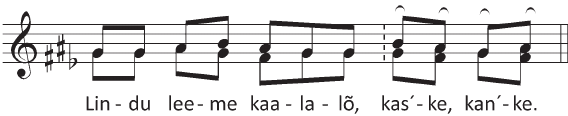
Figure 4: 7-position verses ending with a three-position stress group (2+2+3 structure). The choir of Anne Vabarna, ’[Let us help] the precious dickeybird to an honoured spot’.